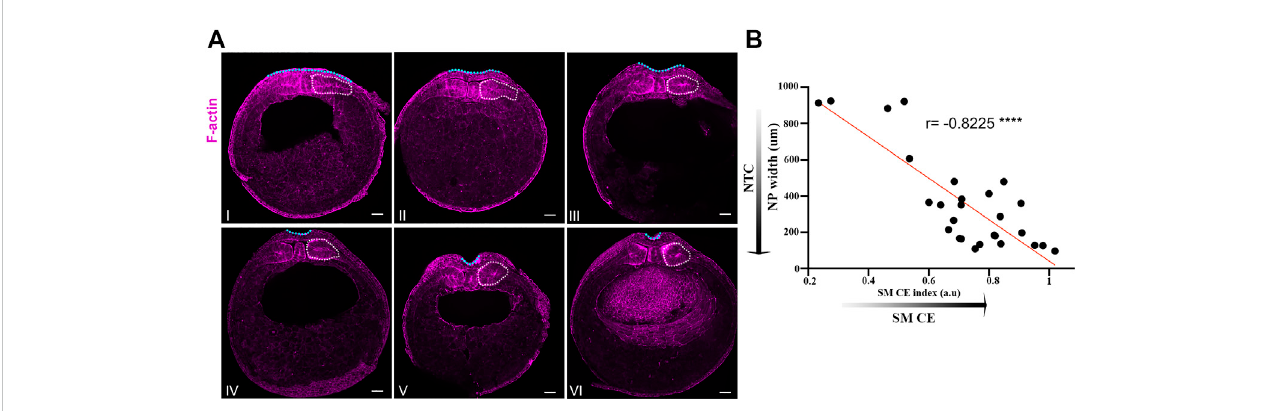
FIGURE 1 Neural plate and somitic mesoderm morphogenesis are temporally linked during neurulation. (A) Transverse cross sections of representative neurula stage Xenopus embryos. Numbering follows neural tube closure progression judged by neural plate mediolateral length. White dotted outline: Somitic mesoderm. Blue dotted line: Neural plate. Scale bars: 100 μ m. (B) Quanti fi cation of neural plate width relative to somitic mesoderm convergent extension index (Somitic mesoderm dorsovetral/mediolateral length). Pearson correlation; **** p < .0001; n = 27 embryos. Anti-correlation between neural plate width and somitic mesoderm convergent extension index shows that neural tube closure progression, reduced neural plate width, is highly correlated with progression of somitic mesoderm convergent